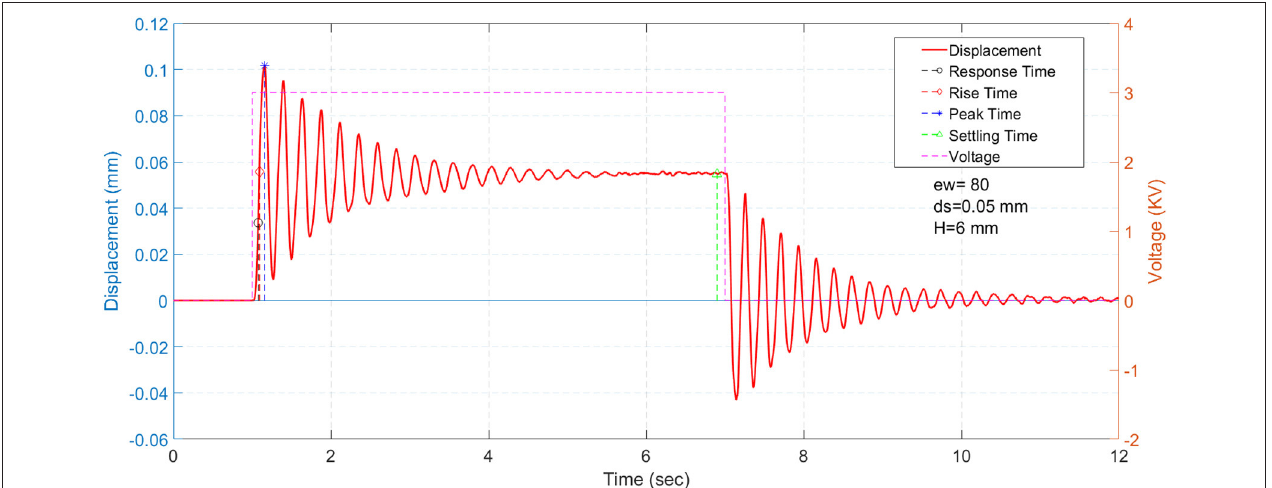
FIGURE 5 | Response of the water droplet to a step voltage of 3 kV.